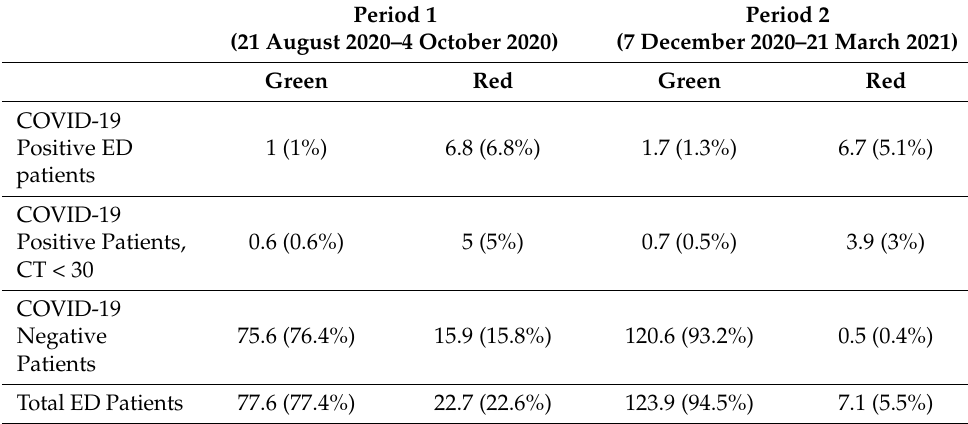
Table 2. The daily average and percentage of ED patients assigned to the green/red EDs during research periods 1 and